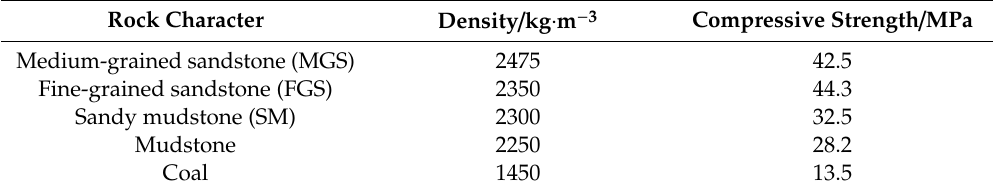
Figure 3. Physical model and measuring line layout. Table 1. The properties of the roof strata of the 121,302 working face.